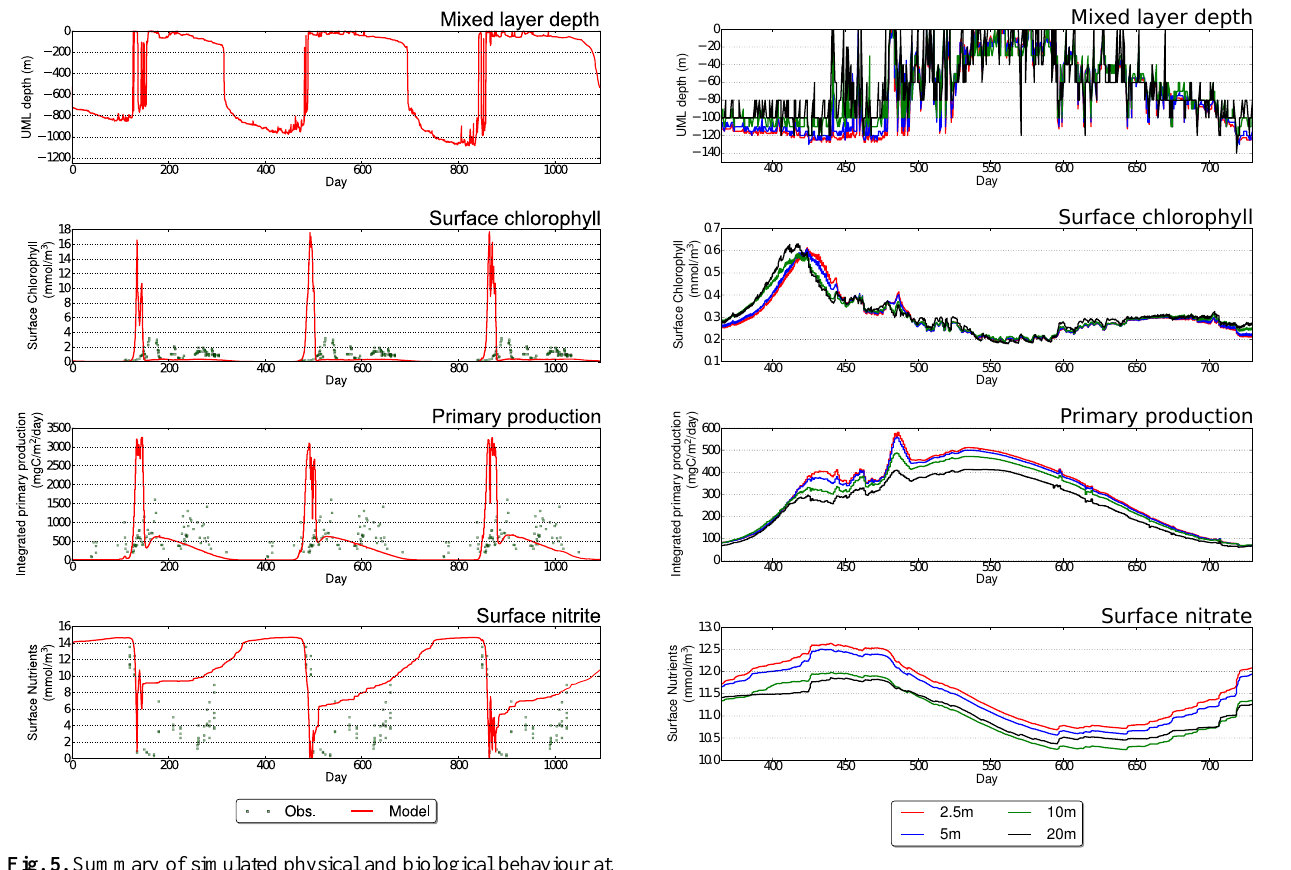
Fig. 6. Summary of simulated physical and biological behaviour at Station Papa using uniform meshes at a number of resolutions. From top to bottom, panels show MLD, surface chlorophyll, integrated primary productivity and surface